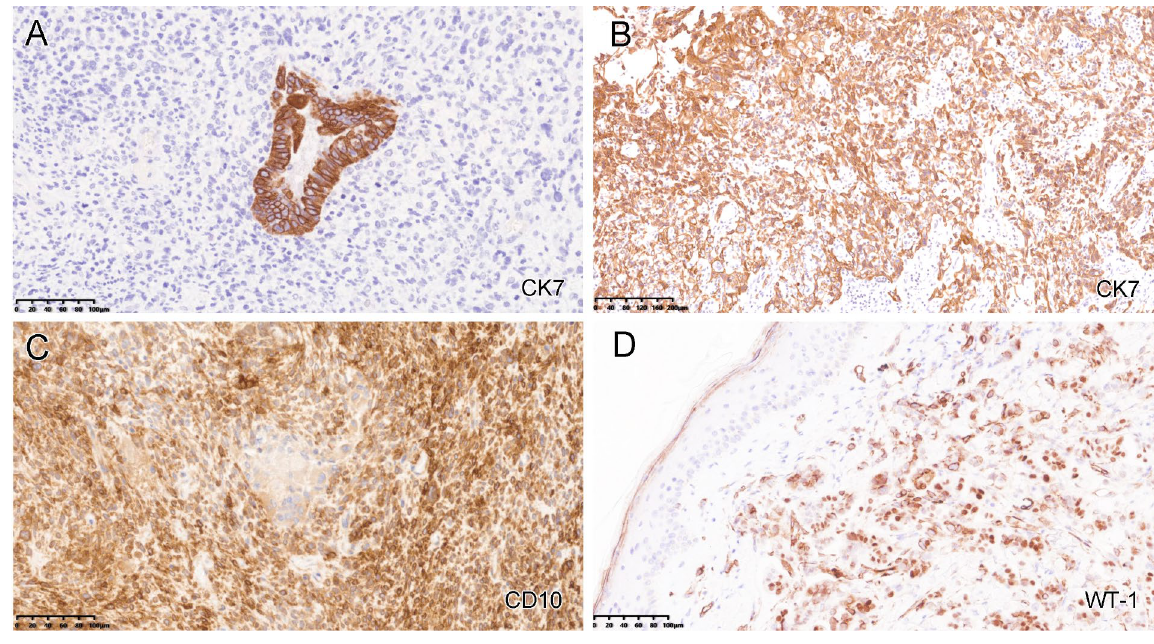
Fig. 2 Immunohistochemical findings in ovarian carcinosarcoma and metastatic carcinoma in the skin. The carcinomatous component of carcinosar- coma, corresponding to Fig.1C and 1D, was diffusely positive for CK-7 (A and B), whereas the sarcomatous component was positive for CD10 (C). The metastatic carcinoma was positive for WT-1